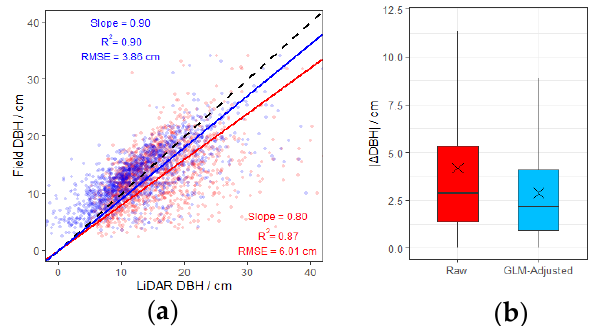
Figure 4. Relationship between the lidar-estimated and field-measured DBH values, and the estimation absolute error before and after correction based on the transformation model. ( a ) Cross-origin linear fitting of DBH lidar estimated and field measured values. The red points and line are the fitting results before correction. The blue points and line are the fitting results after correction. The black dotted line represents y = x. ( b ) Absolute errors (| ∆ DBH|) of lidar measurements before and after correction. In the figure, × denotes the mean values. The differences are significant according to analysis of variance ( p < 0.05).